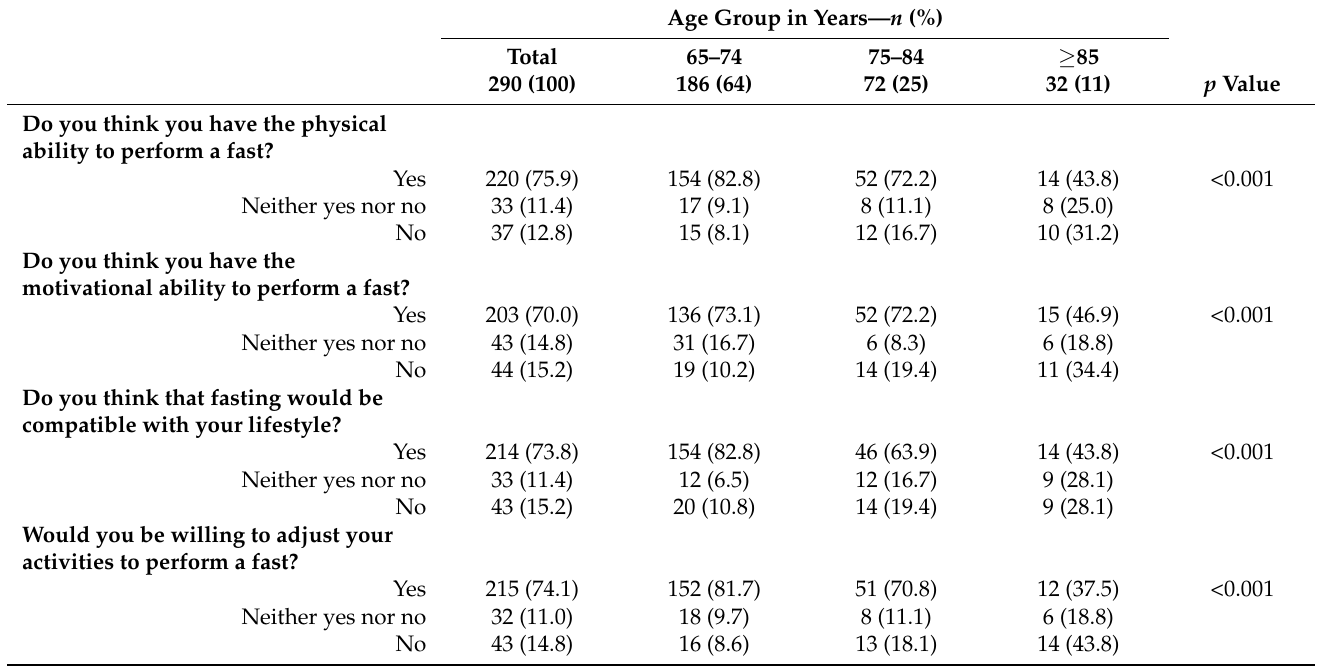
Table 2. Relationship between age group and attitude towards fasting-mimicking diet-like (FMD-like). Age Group in Years— n (%) Total 65–74 75–84 290 (100) 186